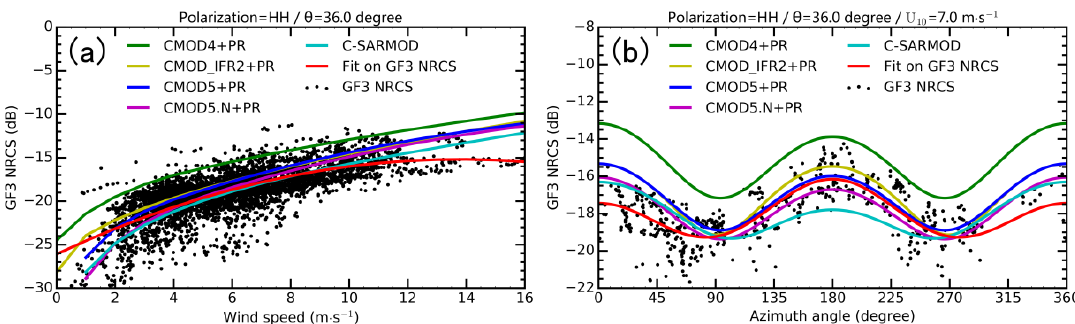
Figure 8. Same as Figure 5, but for HH polarization. The PR model used was developed using GF-3 data, shown in Equation (5).